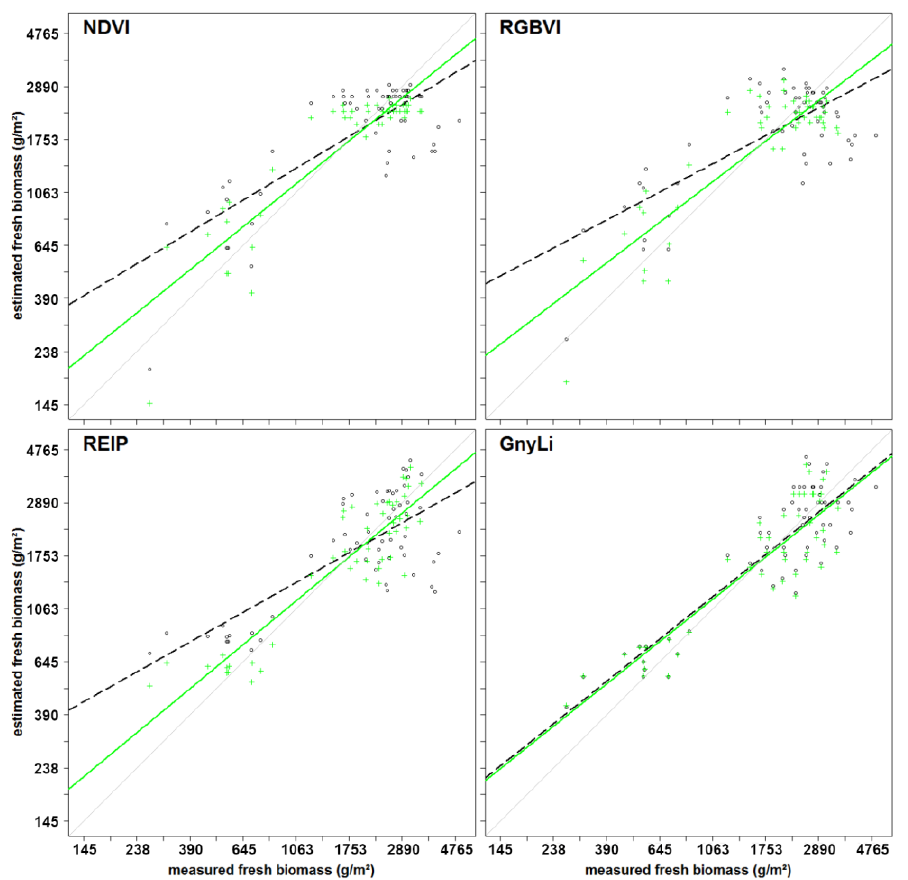
Figure 6. Scatterplots of measured vs. estimated fresh biomass for one validation data set for NDVI, RGBVI REIP, and GnyLi (exponential model). Pre-anthesis: crosses and solid green line; whole observed period: circles and dashed black line; 1:1 line: light